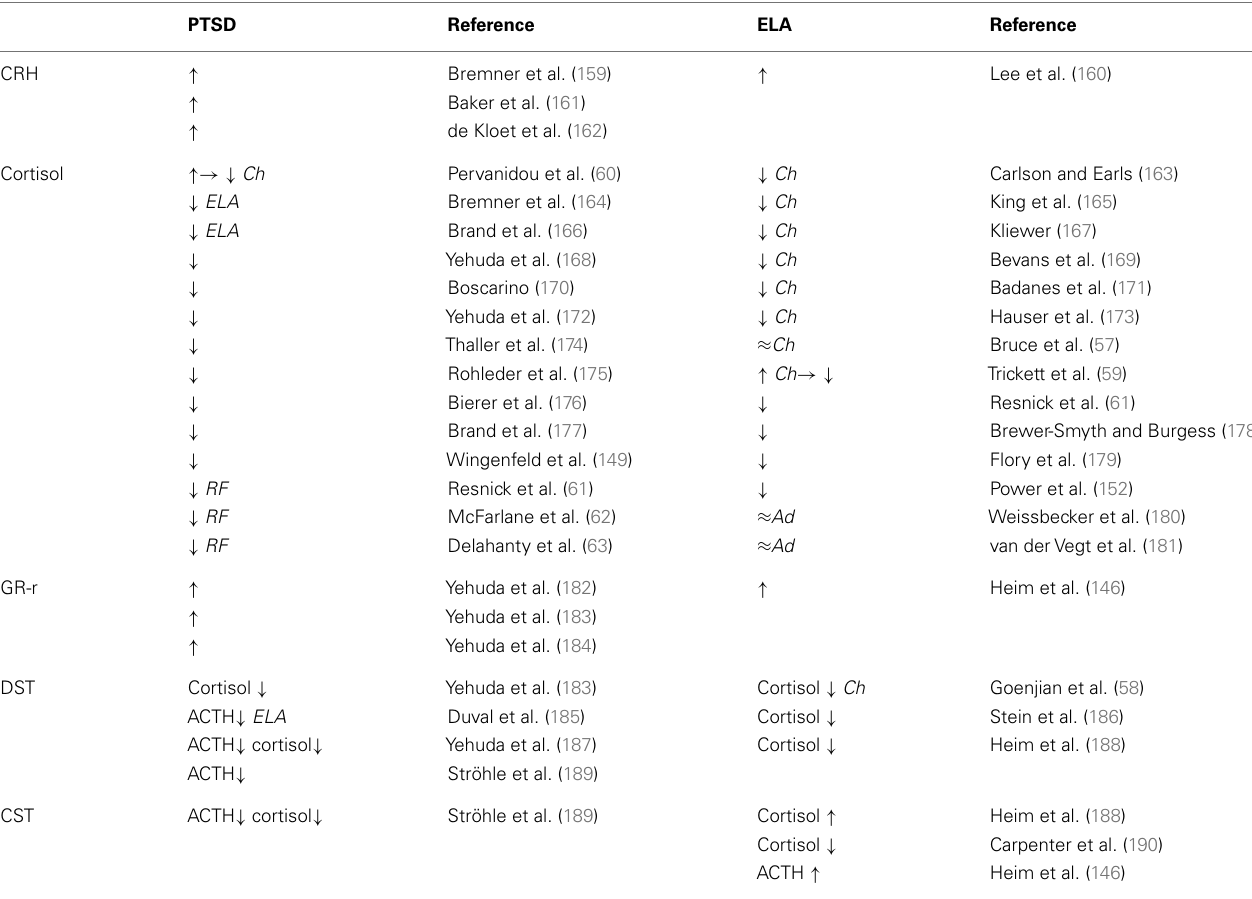
Table 2 | Neuroendocrine status in PTSD patients without and with a history of early life adversity and in healthy controls exposed to early life